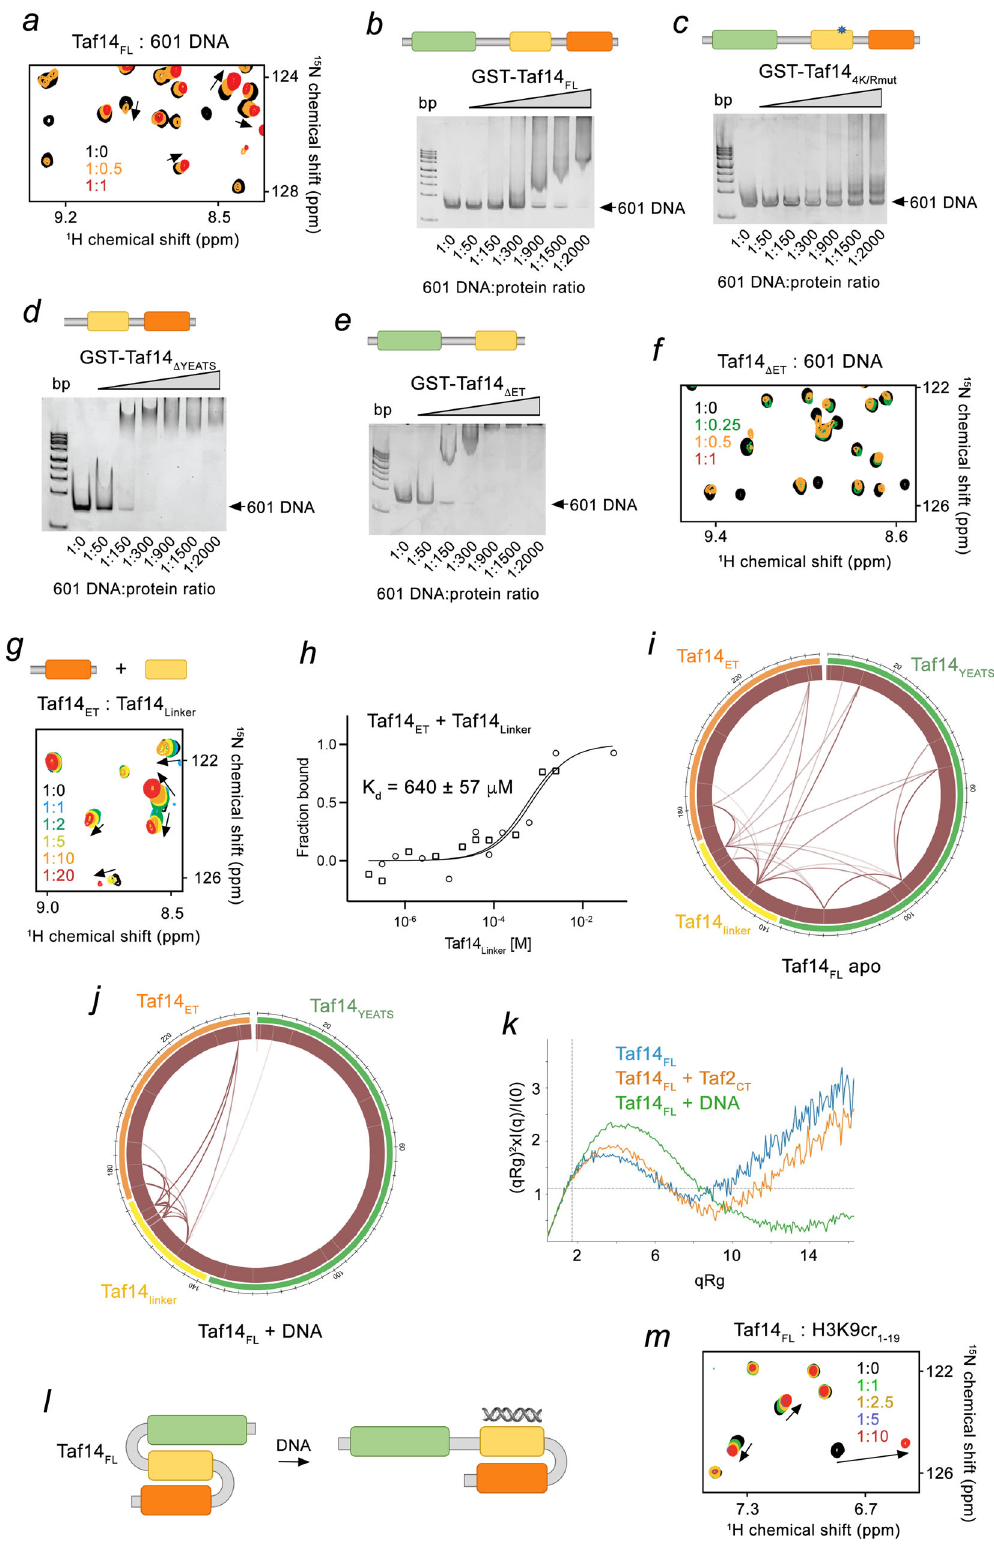
Taf3, Taf7 and Taf8 but not Taf14, in co-IP assays (Fig. 4k). Collectively, these results suggest that the Taf14-dependent and Taf2-dependent interactions with promoter DNA provide a synergistic effect substantially impacting both growth and steady state RNA levels and therefore are important for the regulation of gene transcription in